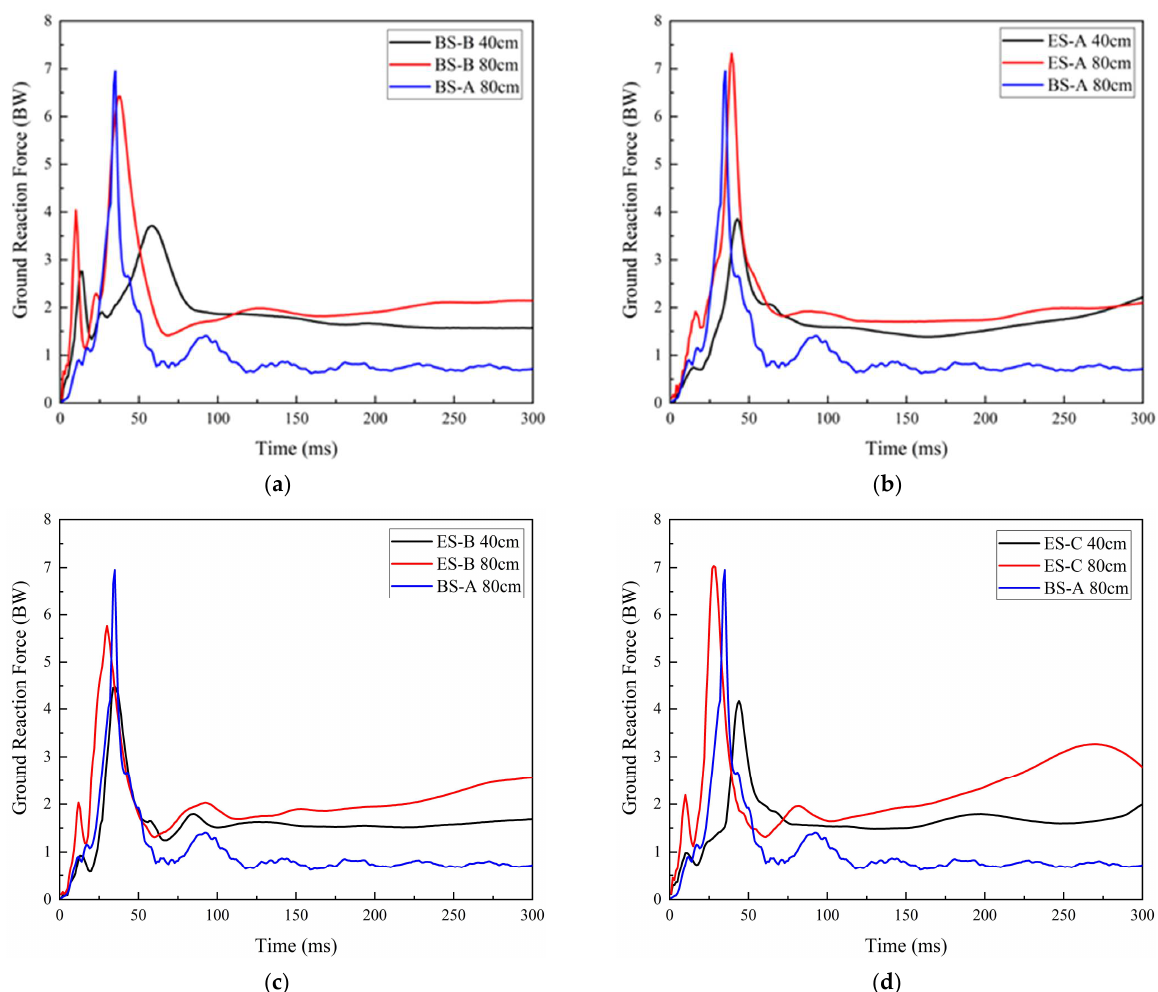
Figure 10. Representative ground reaction force curve of each working condition: ( a ) BS-B; ( b ) ES-A; ( c ) ES-B; ( d ) ES-C.